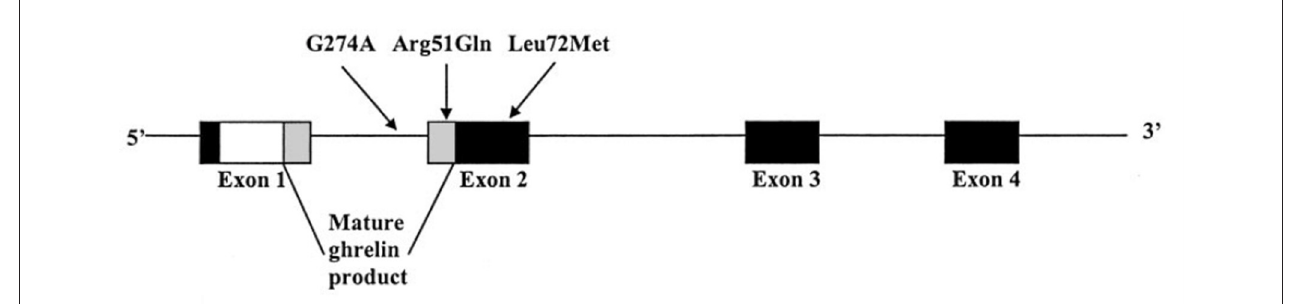
FIGURE 1 | Structure of the preproghrelin gene and sites of the mutations